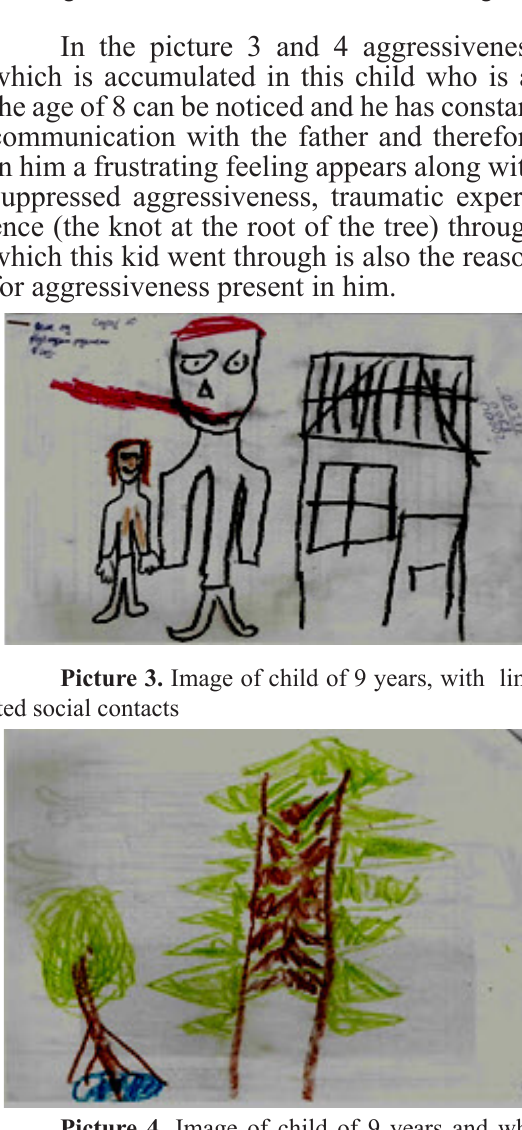
Picture 4. Image of child of 9 years and who has the interrupted communication with the father.